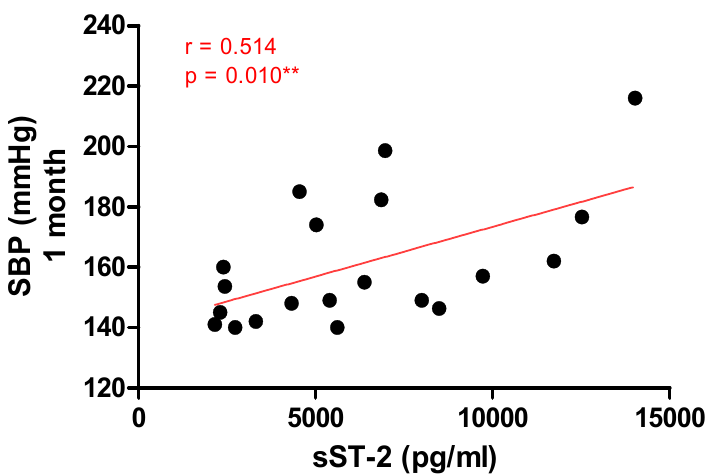
Figure 3. Pearson’s correlation of baseline sST-2 levels with SBP one month after RSD revealed a significant correlation. ** marks statistical significance.